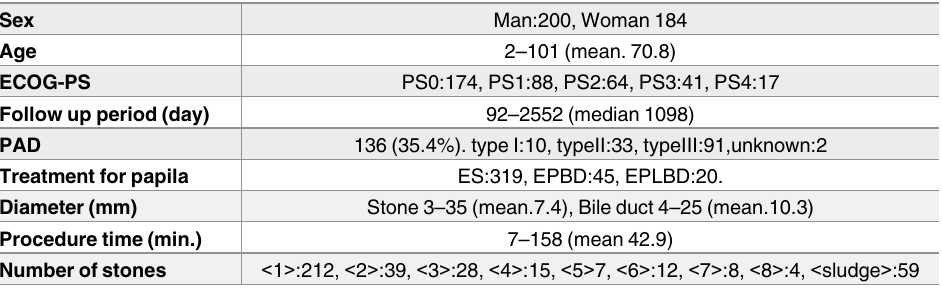
Table 1. Patients characteristics.